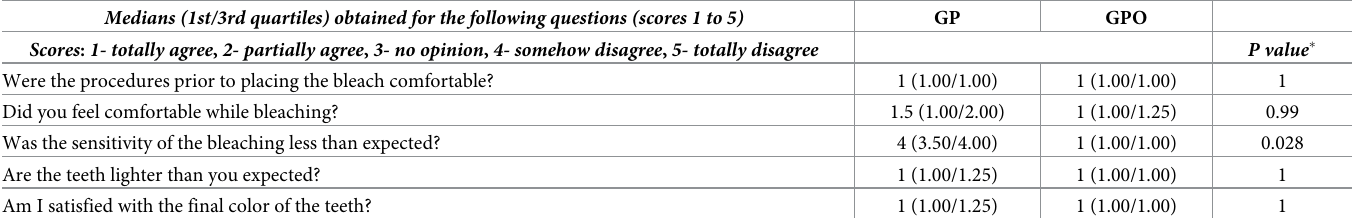
Table 4. Answers to questions assessing patient satisfaction with the bleaching procedure performed. Medians (1st/3rd quartiles) obtained for the following questions (scores 1 to 5) GP GPO Scores : 1- totally agree , 2- partially agree , 3- no opinion , 4- somehow disagree , 5- totally disagree P value � Were the procedures prior to placing the bleach